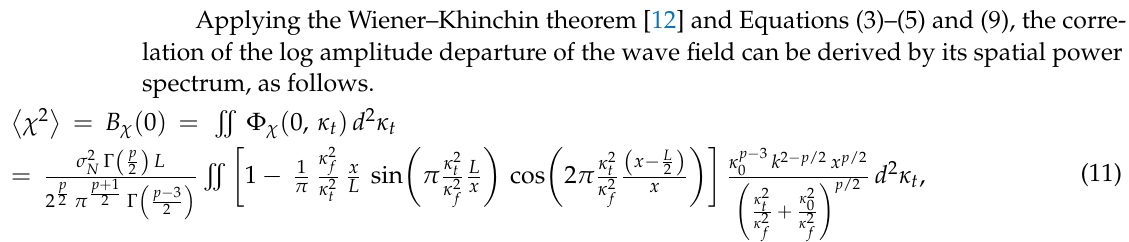
Figure 2. A Fresnel filter function of normalized wave number κ t/ κ F in log scale (shown as the red line). The theoretical spectrum of the log amplitude departure of the wave field as a function of the normalized wave number κ t/ κ F is also shown as the blue line.